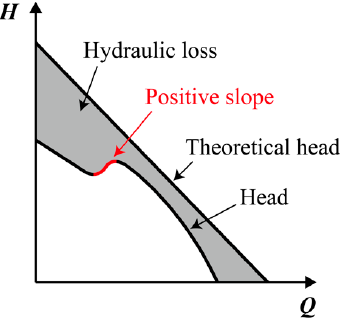
Figure 2. Positive slope in pump performance curve.